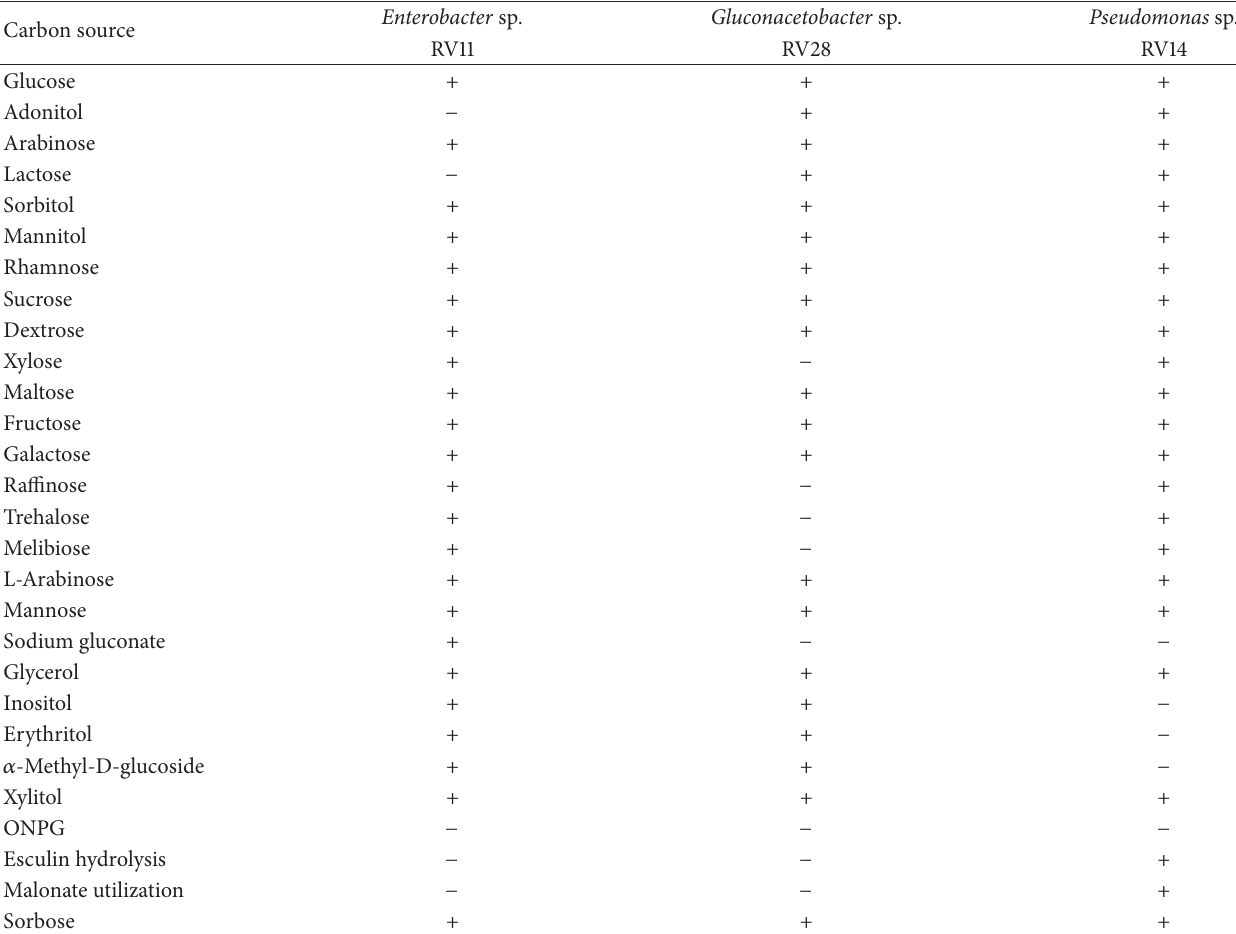
Table 2: Carbohydrate fermentation